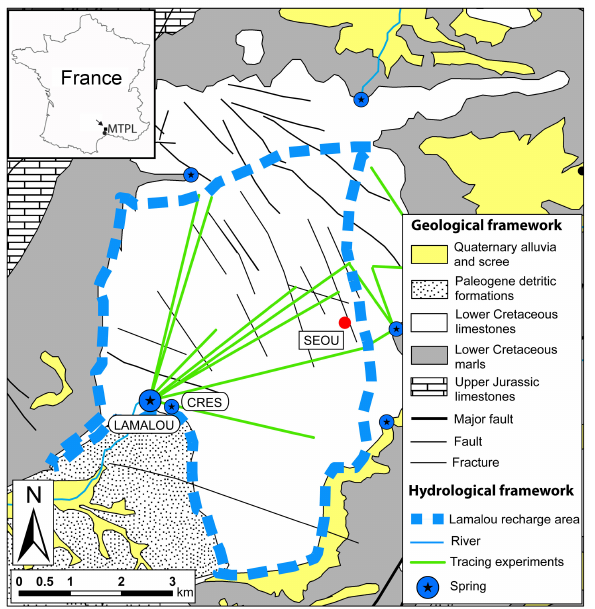
Figure 2. Hydrogeological setting of Lamalou karst system on the Hortus plateau. Seoubio cave (SEOU) is indicated by a red dot; MTPL shows the location of Montpellier city as a landmark.